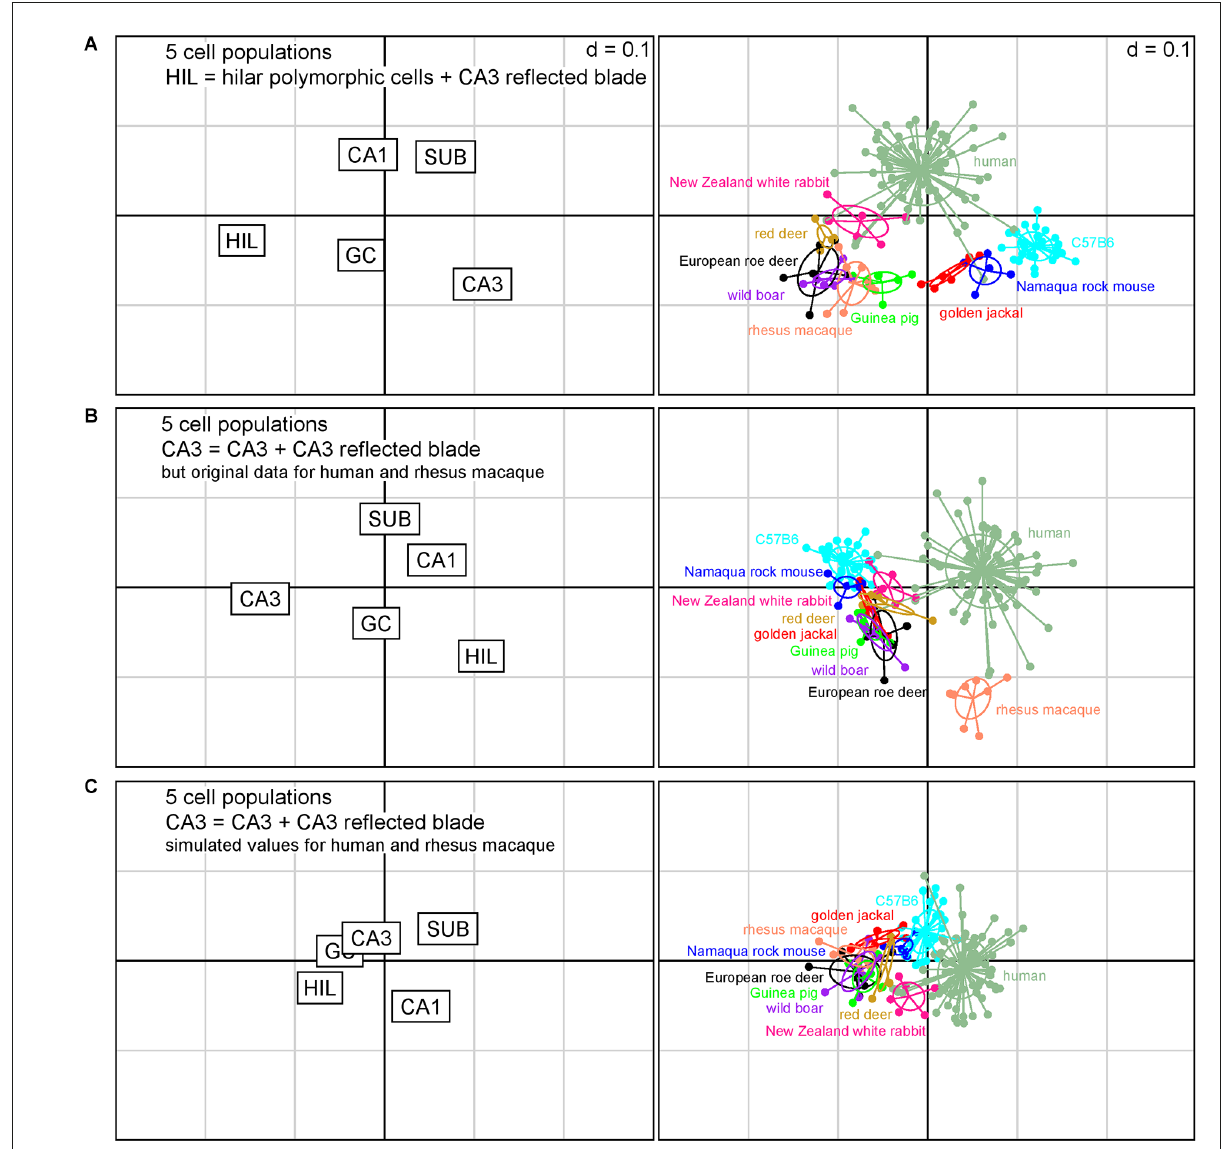
FIGURE4 Correspondence analysis including in addition laboratory mice, rhesus macaque and humans. The plots of hippocampal principal cell populations (left) show their power to separate species (right). (A) Reflected blade neurons were pooled with hilar polymorphic cells. The seven species retain their relations also in the context of the three additional datasets from C57B6 mice, humans, and macaque monkeys. (B) Reflected blade neurons were pooled with the remainder of CA3 in the present species, while the reflected blade remained with a hilar cell population in humans and macaque monkeys. The seven species form a group with C57B6 mice, while separating from humans and macaque monkeys. (C) Simulated values for reflected blade and hilar polymorphic populations were calculated for humans and macaque monkeys based on the rabbit data and reflected blade numbers of all species were pooled with the remainder of CA3. All species fall into a cluster with relatively little differentiation between the species.